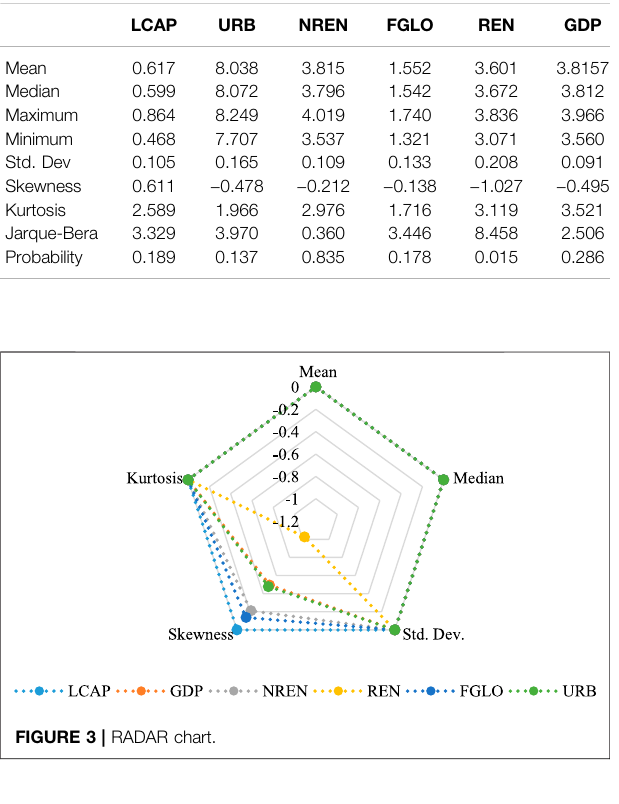
TABLE 4 | ARDL approach to